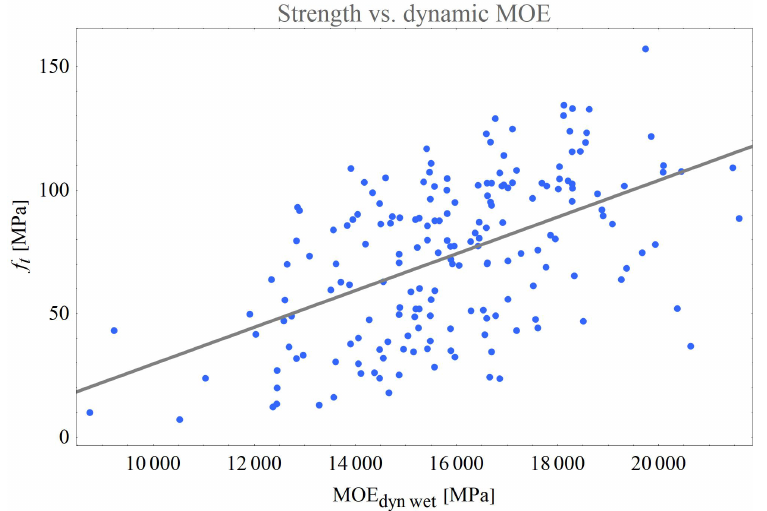
Figure 19. Comparison of tensile strength and dynamic MOE from boards at wet moisture